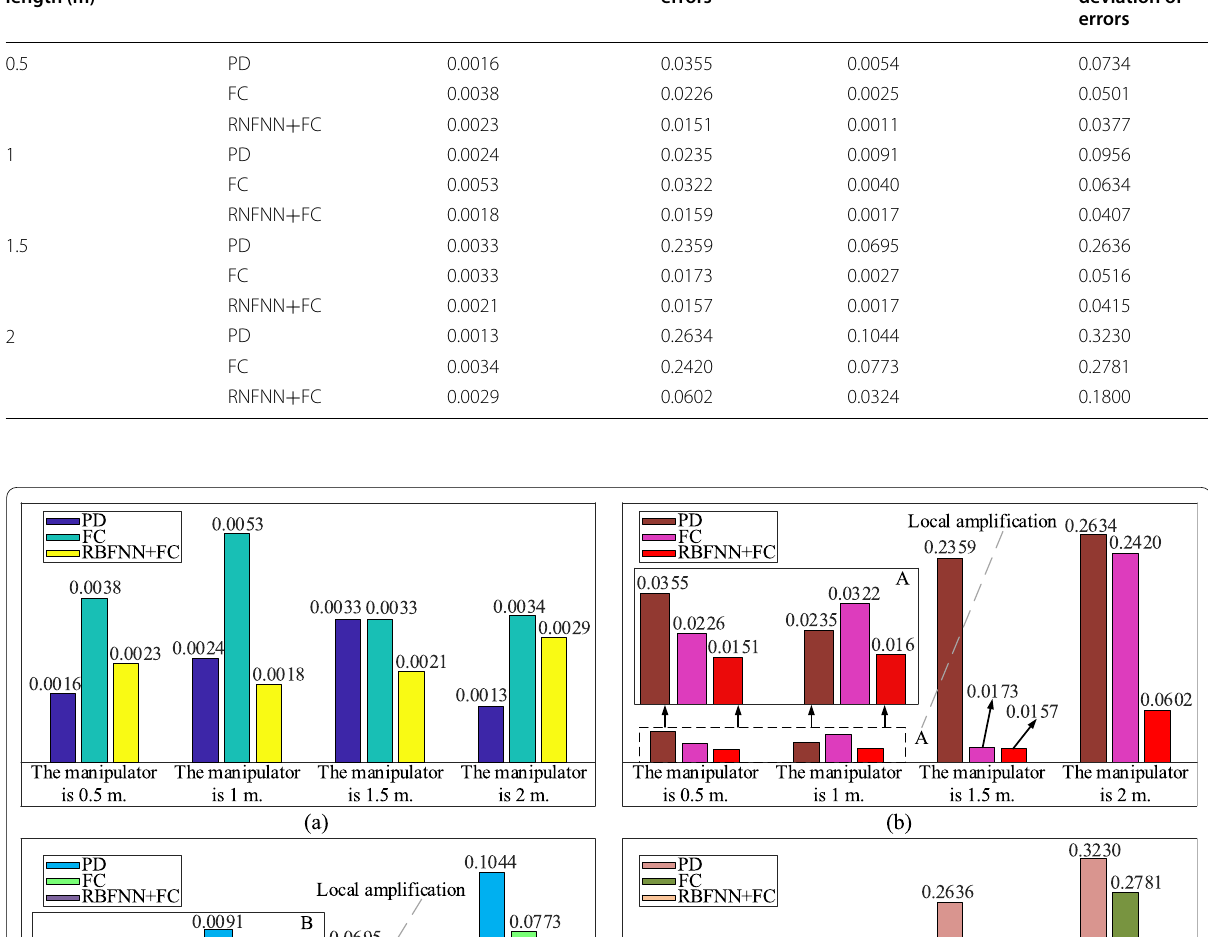
Table 4 Evaluation index of experimental error Flexible manipulator’s length (m)